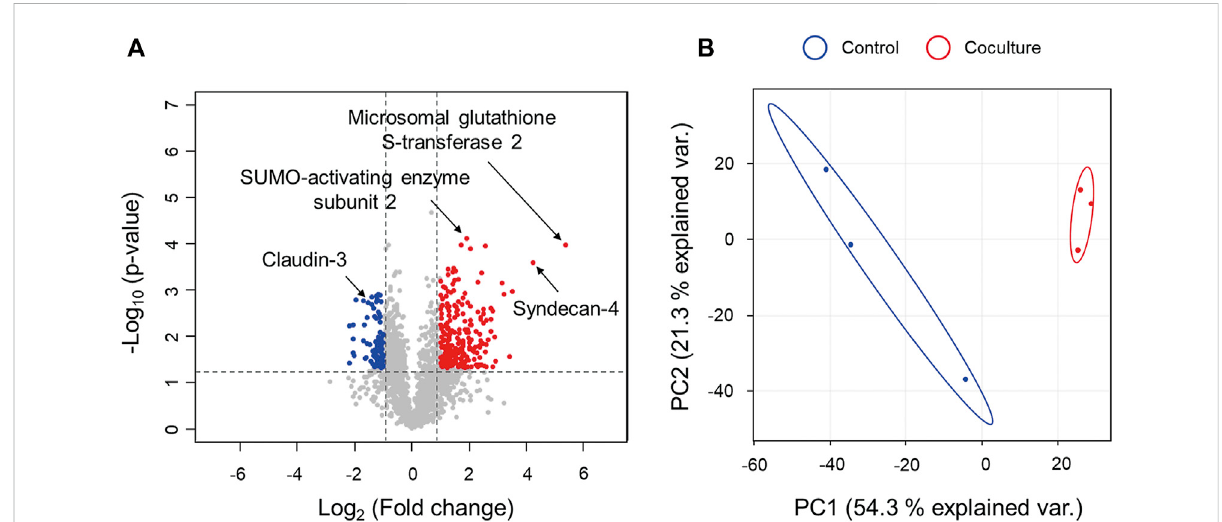
FIGURE 4 Comparison of proteomics results for Caco-2 cells in coculture with C. dif fi cile at 12 h versus monoculture. (A) Volcano plot for comparison of proteomic differences with respect to coculture with C. dif fi cile at 12 h. Volcano plots indicate the upregulated proteins of Caco-2 cells during coculture with C. dif fi cile in red circles and downregulated proteins in blue circles. Indications denote the proteins discussed in this study. (B) Principalcomponentanalysis(PCA)plotforcomparisonofproteomicdifferencesaccordingtococulturewith C.dif fi cile at12 h.Controlmeans monoculture of Caco-2 cells. Proteomic analysis was performed in